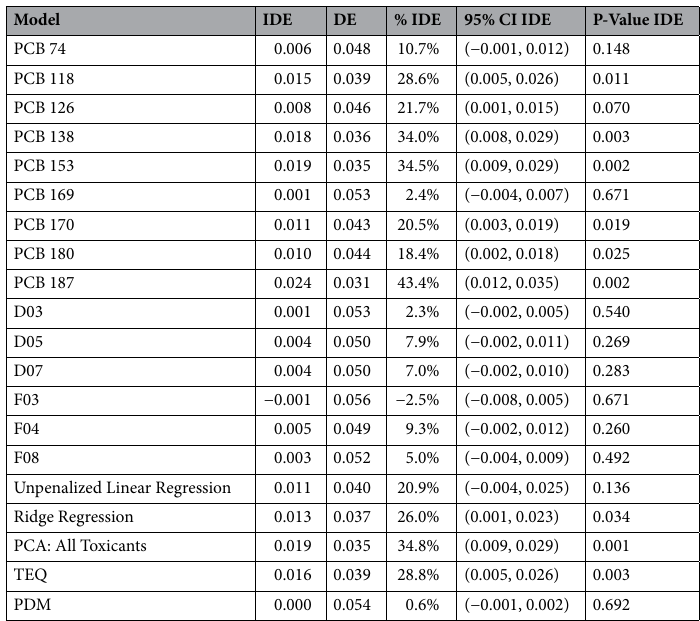
Table 3. Indirect effect and direct effect summary. Presented results include the indirect effect, direct effect, percent indirect effect, and corresponding confidence interval and p-values for the indirect effects across different mediation models. P-values in the single mediator models are corrected for multiple testing using the Benjamini–Hochberg correction.